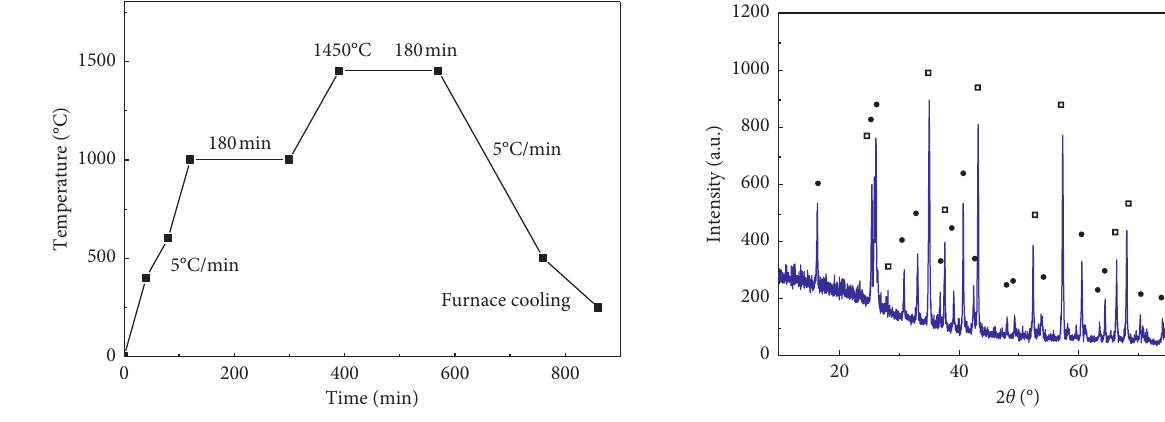
Figure 4: Sintering schedule of the